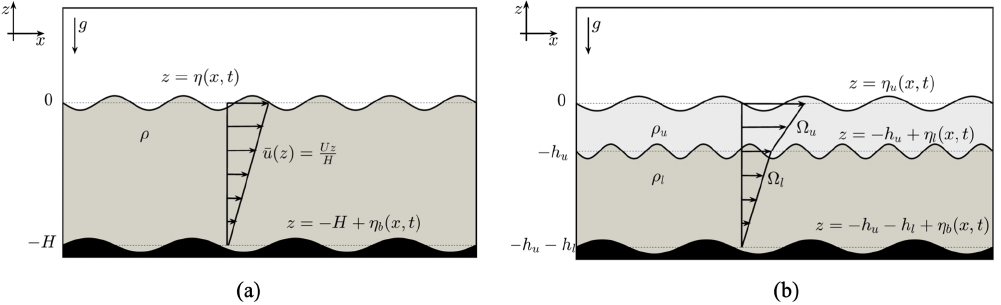
Figure 1. Schematic diagram showing waves over a rippled bottom. The profile of the bottom is η b . (a) One-layered flow of depth H with density ρ is assumed. The free surface profile is η . The velocity profile (chosen to be linear) must create a Doppler shift between the free surface and the bottom. (b) Two-layered flow of depth H ≡ h u + h l with density ρ u and ρ l is assumed. The free surface (interface) profile is η u ( η l ). The velocity profile is piecewise